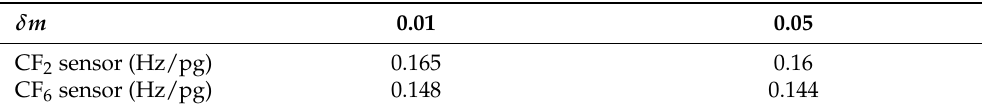
Table 6. Responsivity of bifurcation-based arch microbeam sensors with an initial rise of w o =